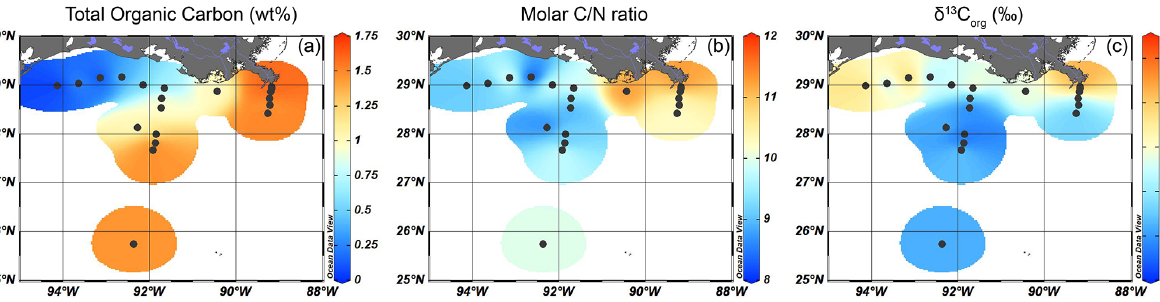
Figure 2. Isosurface plots for bulk sediment properties of surface sediments in the GoM for (a) TOC content (wt%), (b) the molar C / N ratio, and (c) δ 13 C org